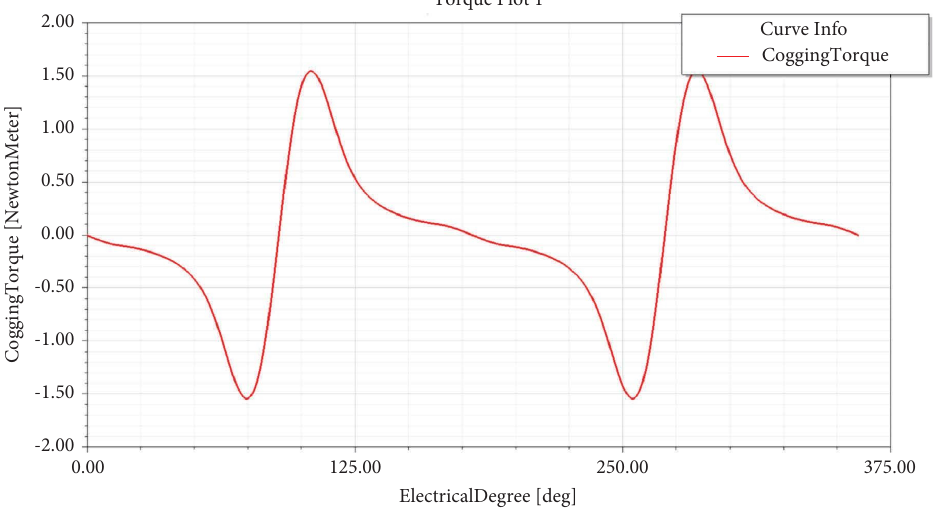
Figure 8: Torque curve 8-pole 24-slot motor.